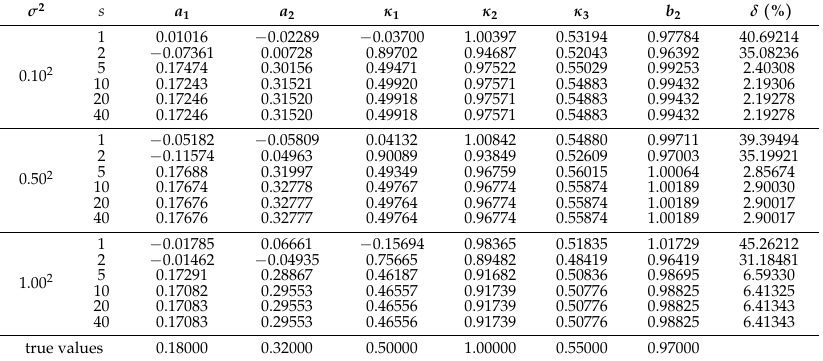
Table 1. The parameter estimates and estimation errors versus s under the proposed VB-KF